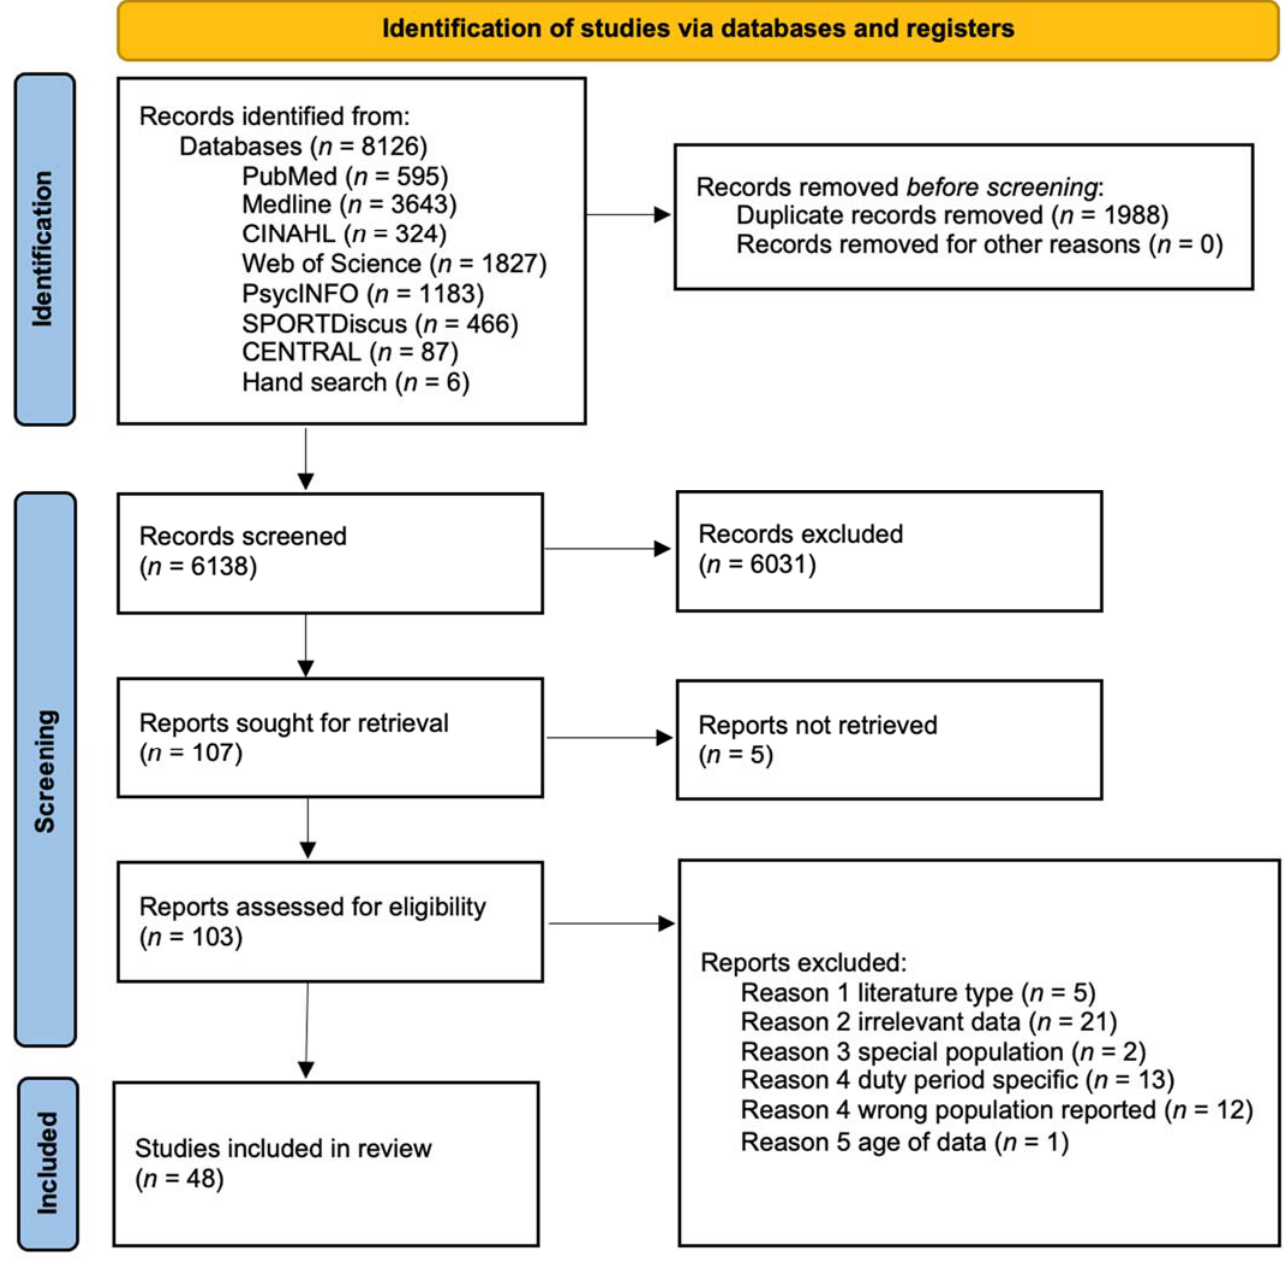
Figure 1. PRISMA flow diagram. PRISMA, Preferred Reporting Items for Systematic Reviews and Meta ‐ Analyses .